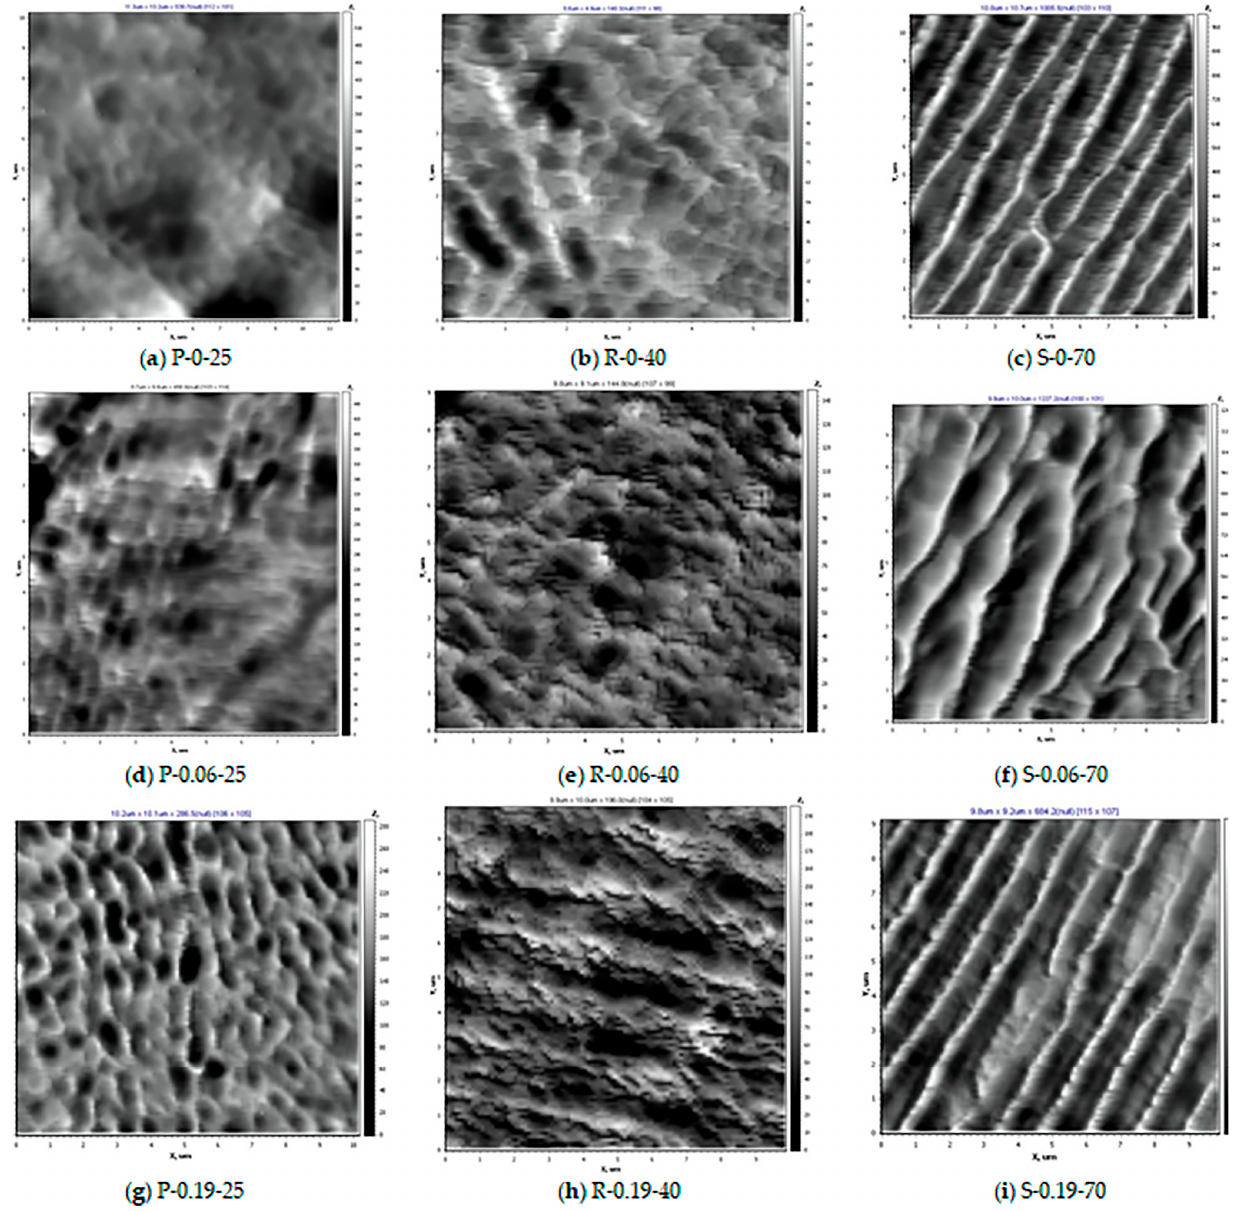
Figure 8. AFM images of the selective layer surfaces of of PPSU and PPSU/O-MWCNT ultrafiltration membranes prepared at coagulation bath temperatures 25 ◦ C ( a – g ), 40 ◦ C ( b – h ), and 70 ◦ C ( c – i ), O-MWCNTs concentrations, wt.%: ( a – c )—0; ( d – f )—0.06; ( g – i